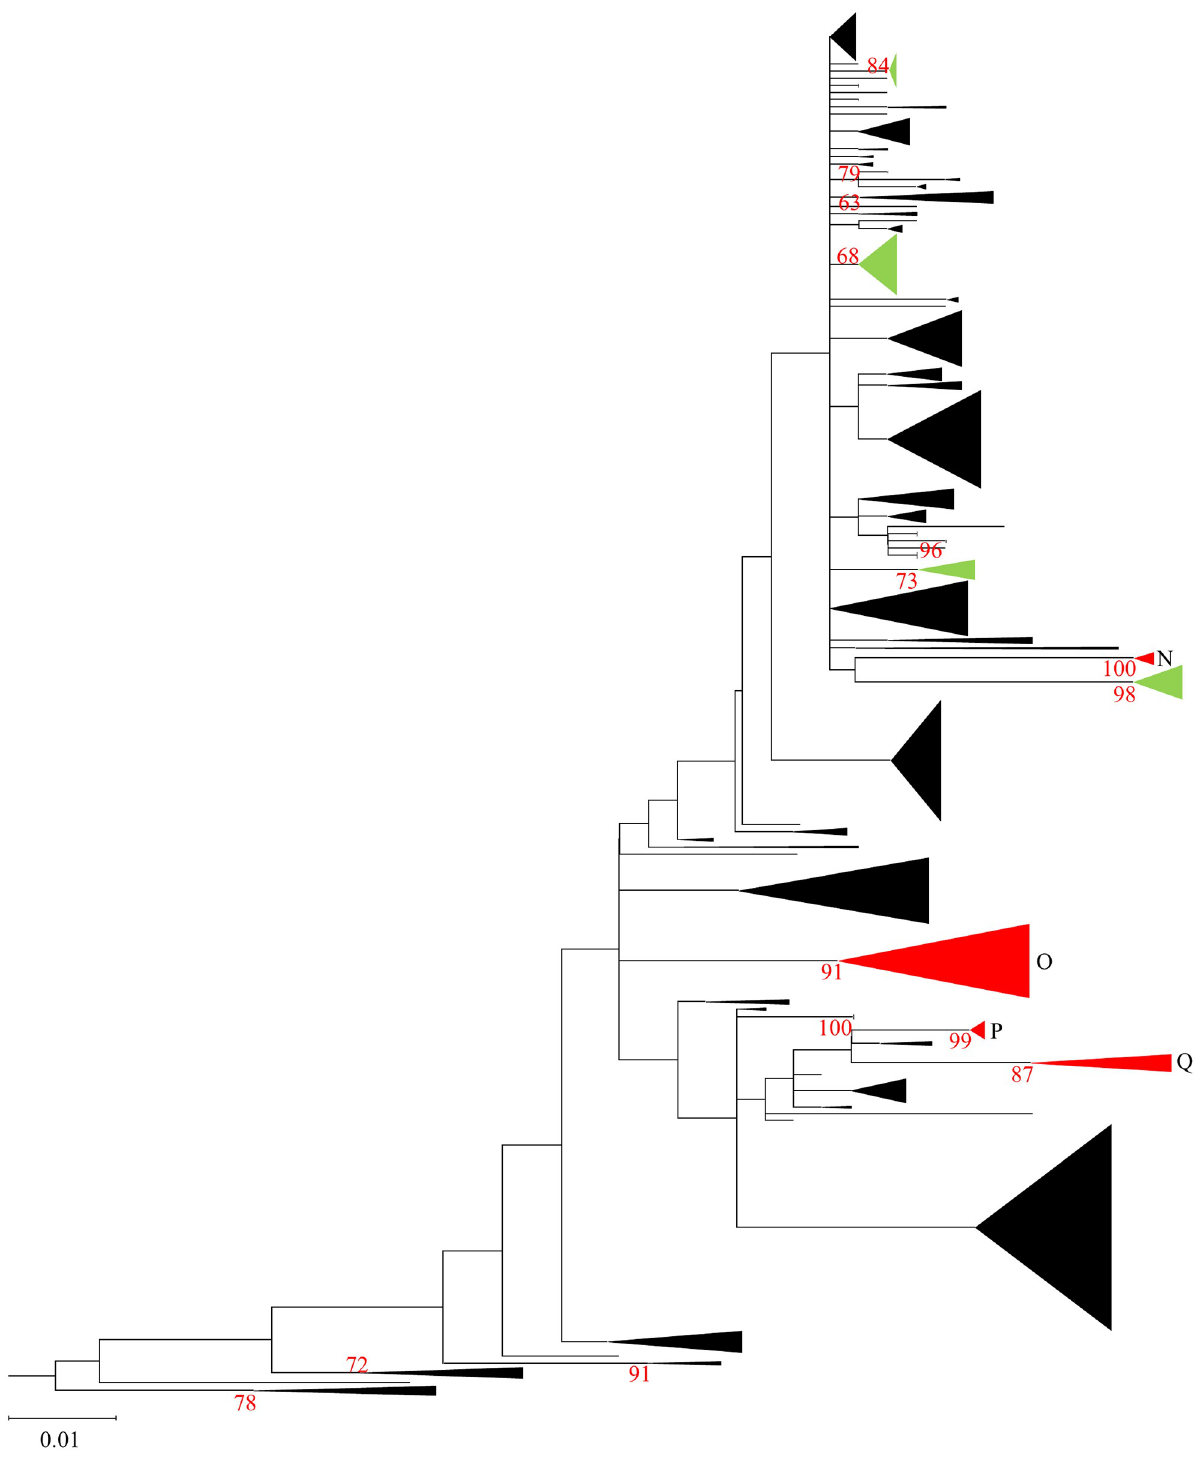
Fig 2. Entire N6 NA maximum likelihood phylogenetic tree composed of genes of viruses analyzed in this study and downloaded from the GISAID databases. AIVs classified as the North American lineage are shown. Identified clades defined on the basis of the rule in this study are in green and red; red clades were selected for phylogeographic analysis and correlation analyses of bird host species and subtypes with phylogeny.